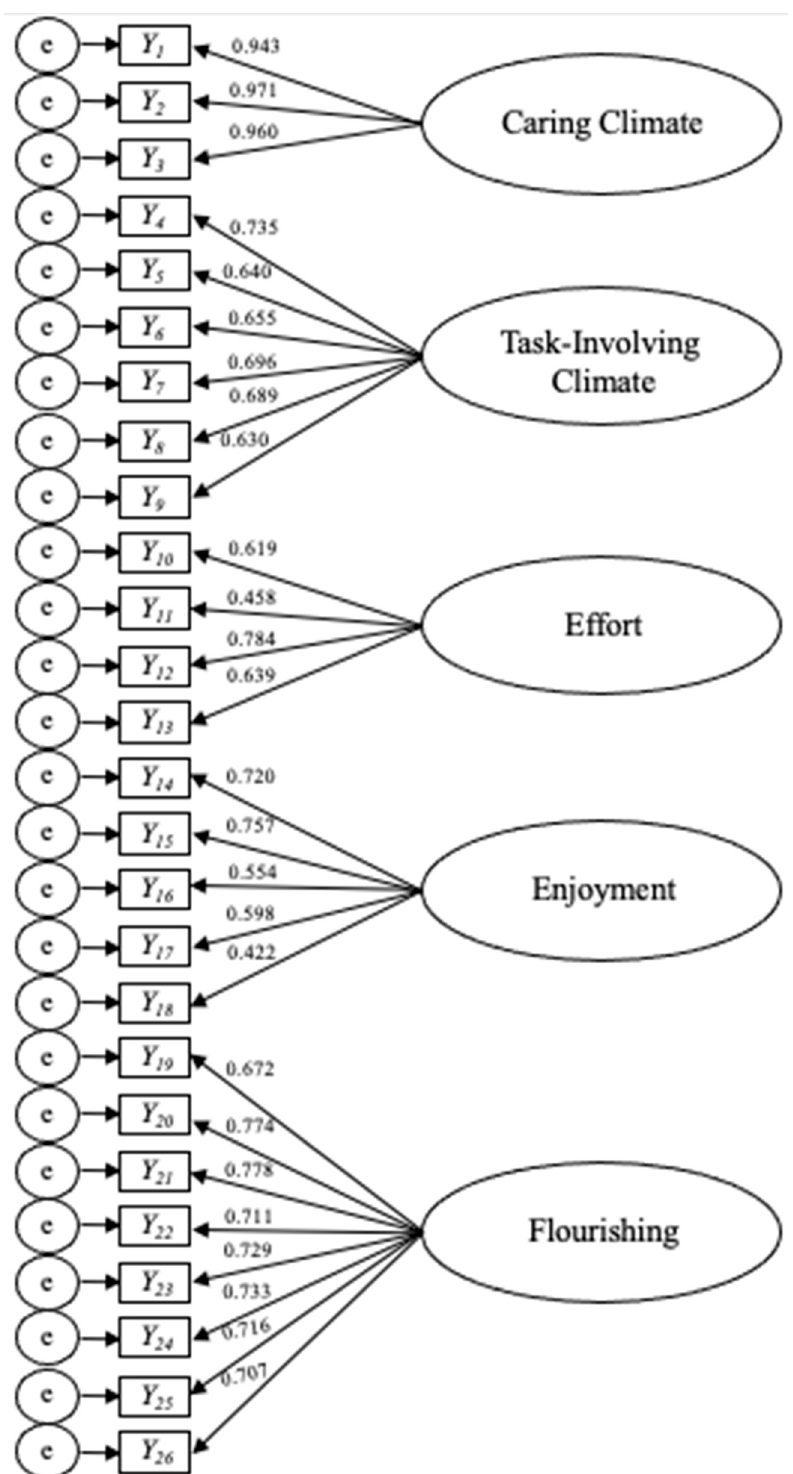
Figure 1. Final Measurement Model. Note: Model fit (CFI = 0.93, TLI = 0.92, RMSEA = 0.06, and SRMR = 0.05). All factor loadings are significant at p < 0.001.